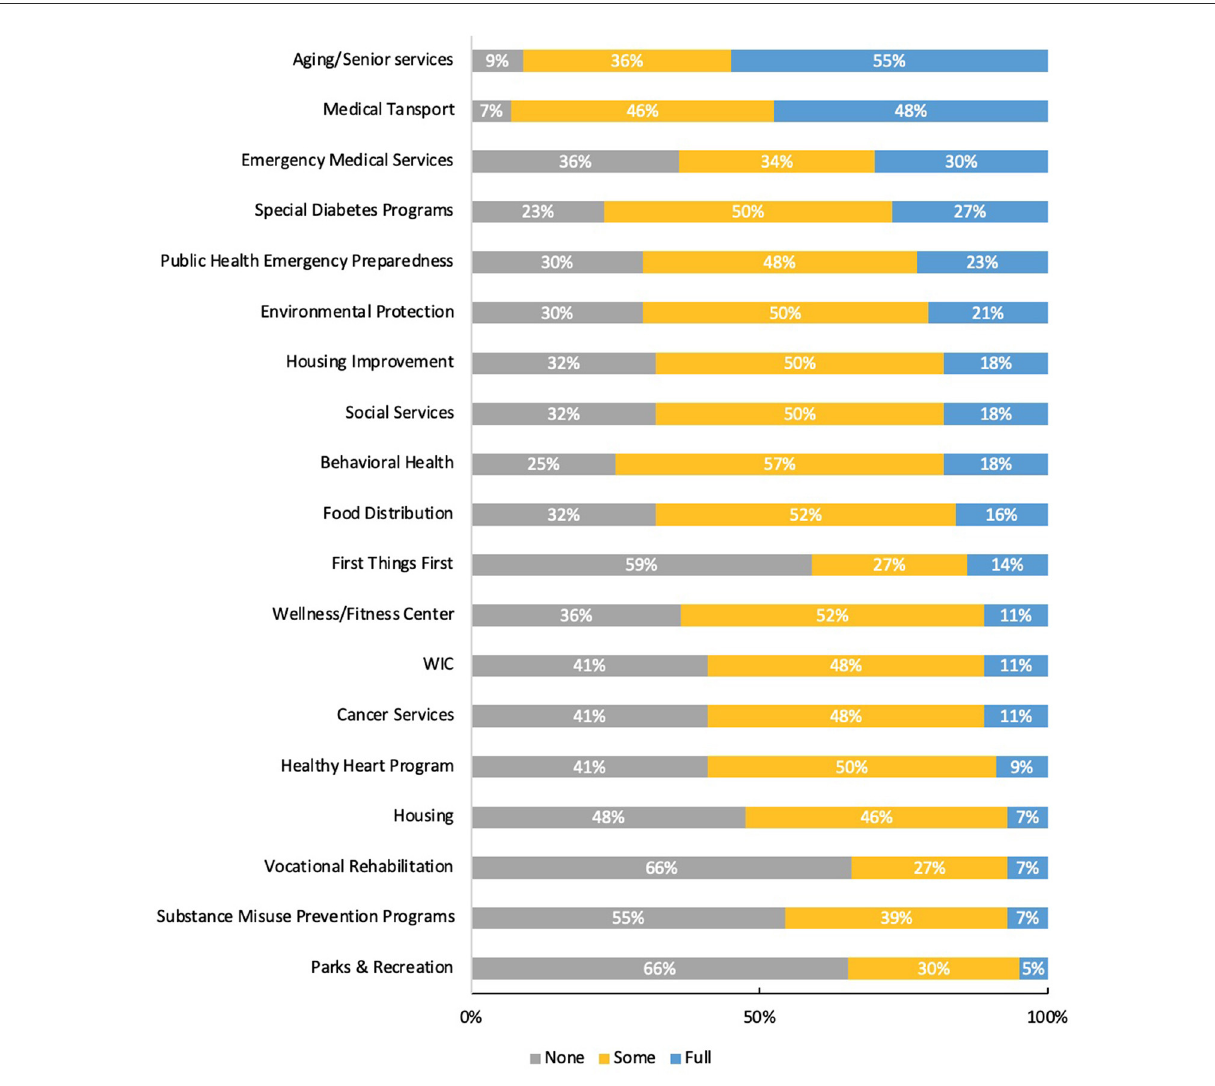
FIGURE1 Collaboration among CHRs and public health services by type and level ( N = 44